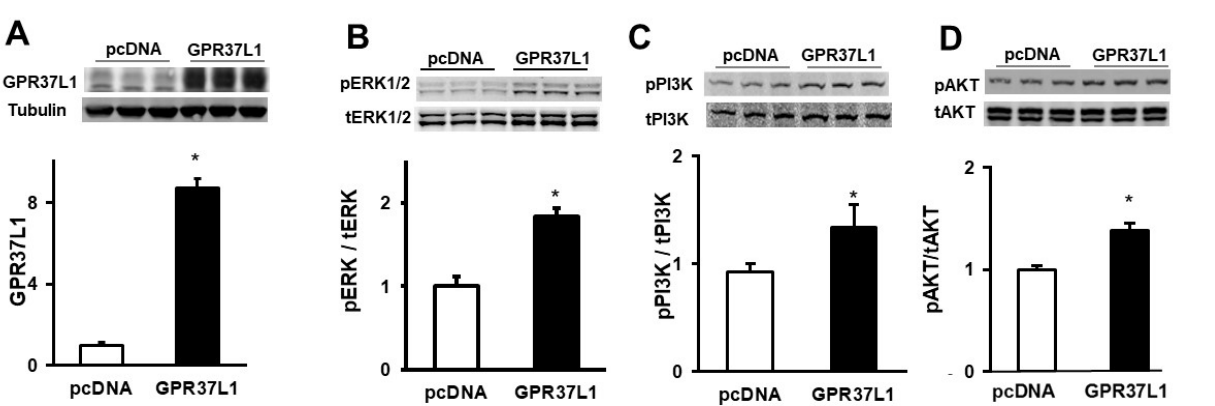
Figure 8. GPR37L1 decreases DNMT1 expression through mTOR. The hRPTCs, transfected with GPR37l1 or control plasmid (pcDNA), were treated with vehicle (Veh) or rapamycin (50 nM [Rap], for 24 h). ( A , B ) Protein preparations from the hRPTCs were immunoblotted for DNMT1. Quantifi- cation of DNMT1 expression normalized by tubulin. n = 3/group, * p < 0.05 vs. pcDNA+Veh, t -te st.